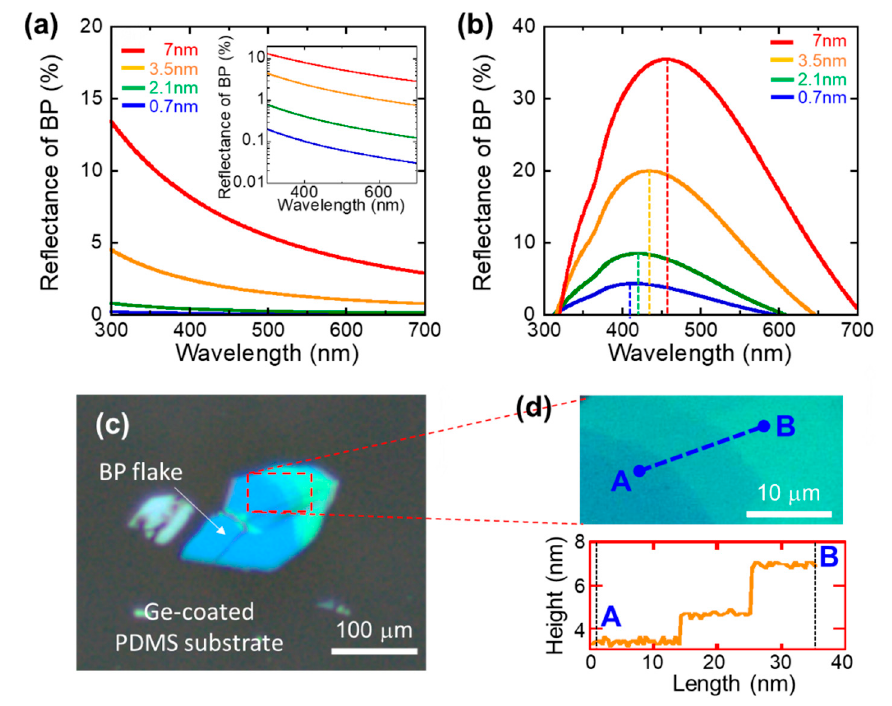
Figure 2. Simulated reflectance of BP on ( a ) a typical PDMS substrate (~30 um) and ( b ) a Ge-coated PDMS substrate (30 um + 200 nm). The inset of Figure 2a is the log-scale reflectance of BP to show the details of reflectance. ( c ) Microscopic image showing typical BP flakes on a Ge-coated PDMS substrate. ( d ) (lower) AFM surface profile between point A and B. (upper) The scanned area is shown.